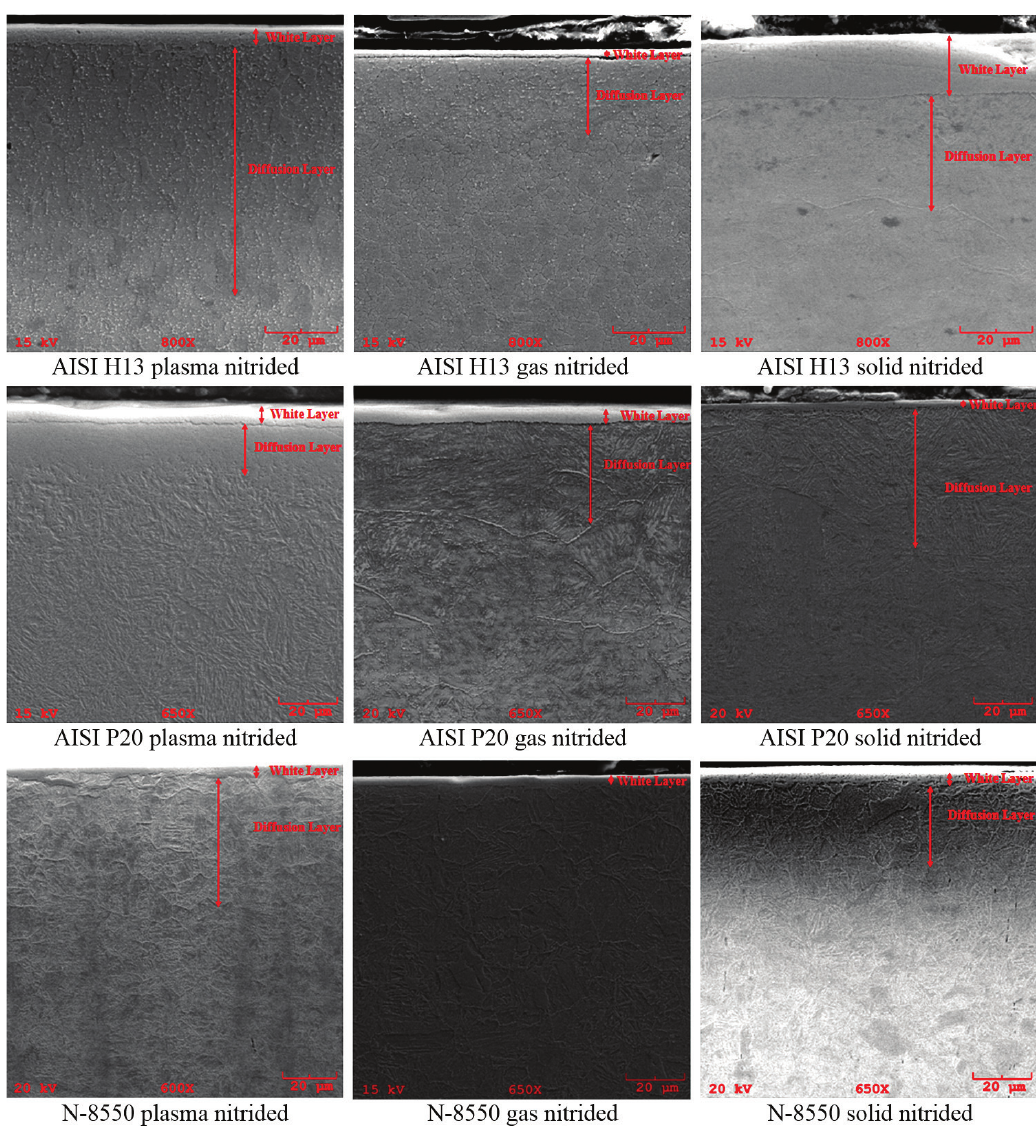
Figure 2. SEM micrographs of AISI H13, AISI P20 and N-8550 cross section, referring to nitrided layers produced by the ntriding treatments.